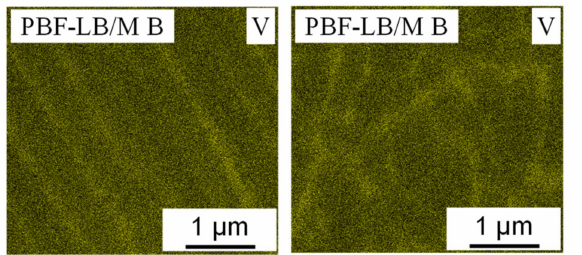
Figure 7. Qualitative EDS maps of the element Vanadium in a PBF-LB/M B sample showing a Vanadium surplus in the interdendrtic areas.